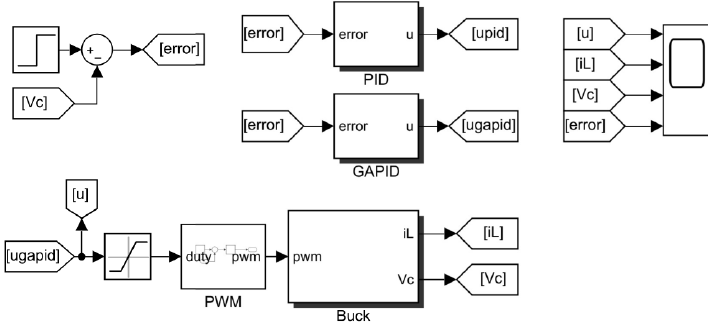
Figure 5. Simulink model of the converter and the control system.